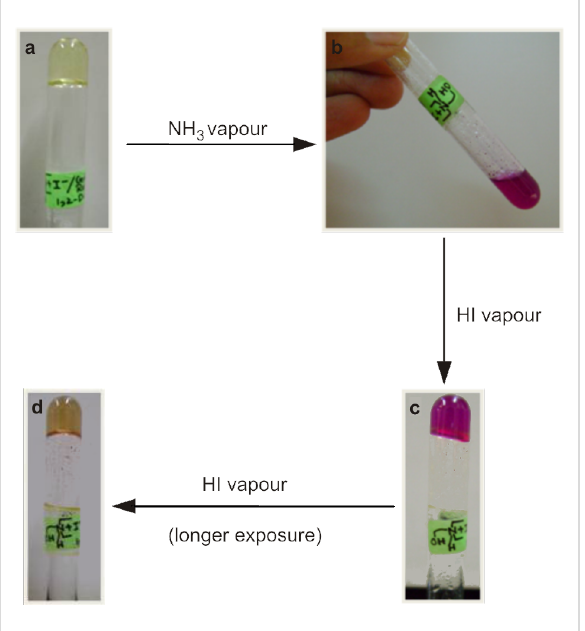
Figure 2: Illustration of base-instability and acid-stability of the organogel of 1 in 1,2-dichlorobenzene.